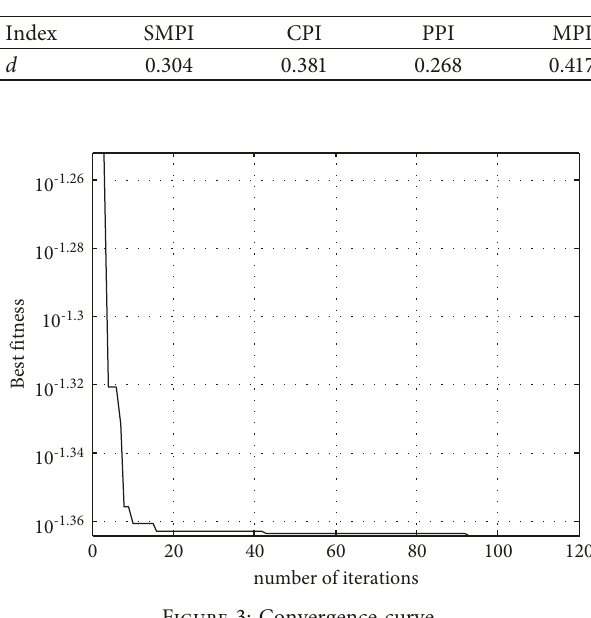
Table 3: Fractional order of each